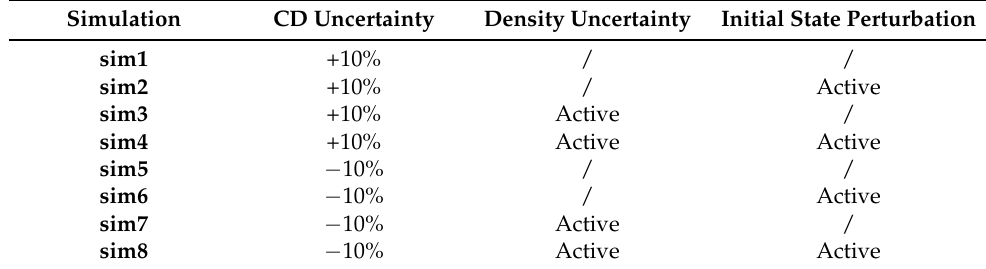
Table 4. Robustness analysis: simulation scenarios. Simulation CD Uncertainty Density Uncertainty